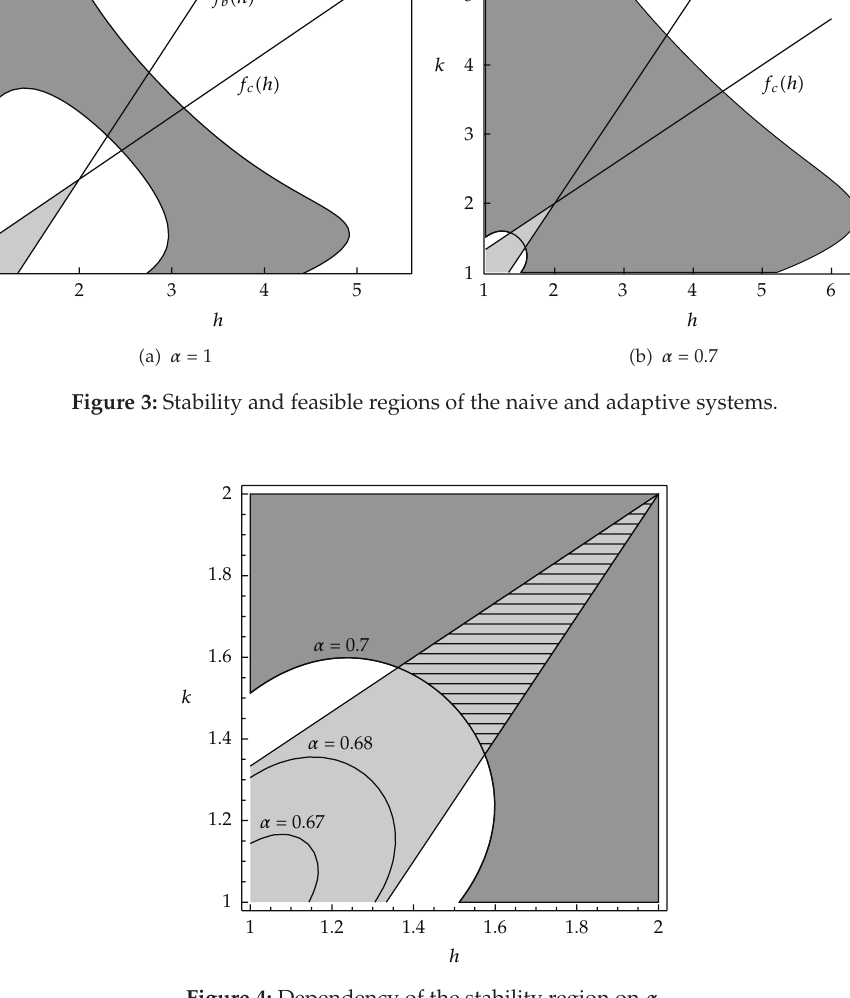
Figure 4: Dependency of the stability region on α